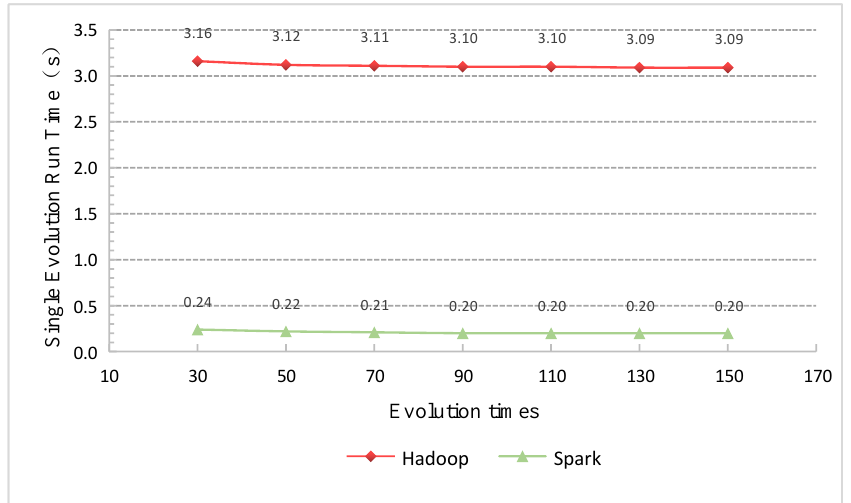
Figure 12. Comparison of the run time of a single iteration of GAESMPF.